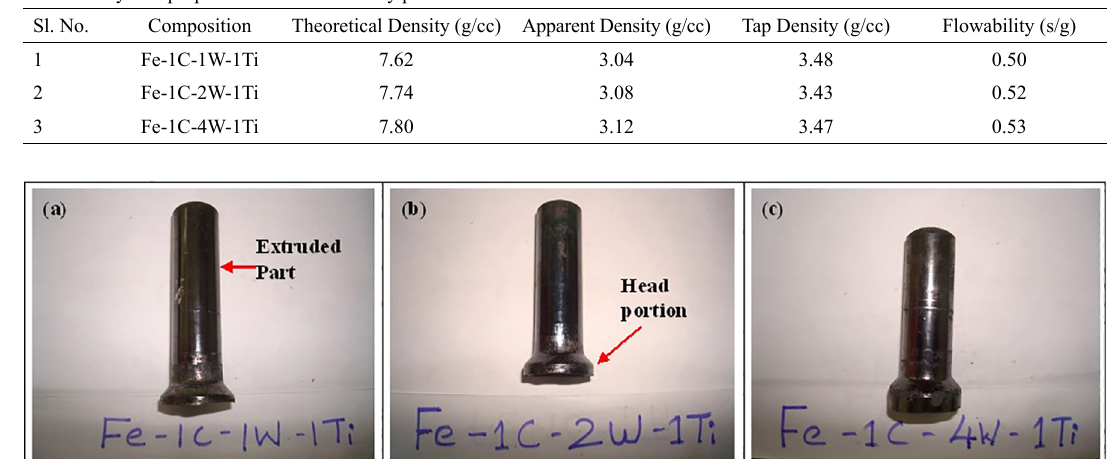
Figure 1. Extruded P/M alloy steels (a) Fe-1%C-1%W-1%Ti; (b) Fe-1%C-2%W-1%Ti; (c) Fe-1%C-4%W-1%Ti Table 2. Hardness values of P/M alloy steels for both as-sintered and hot extruded Sl.